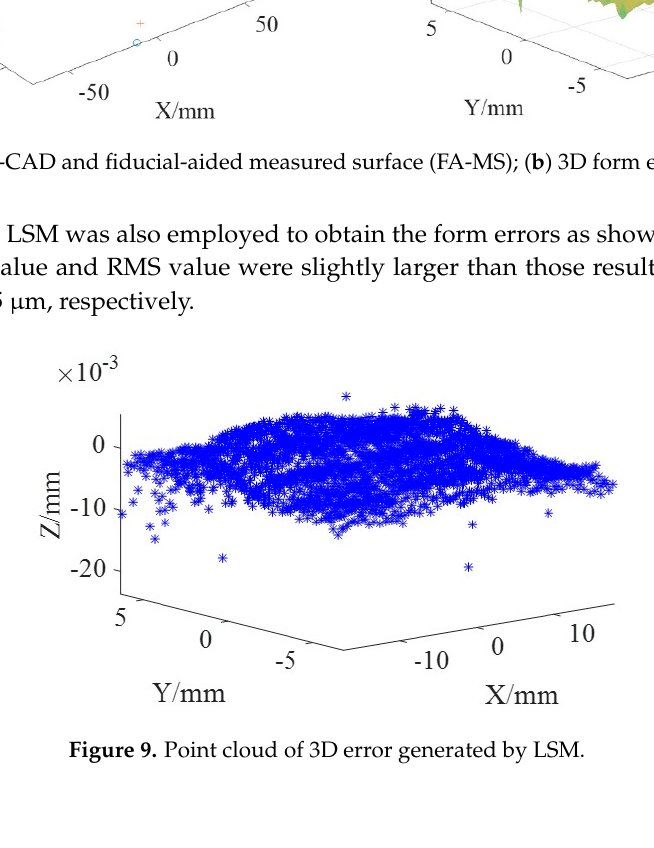
Figure 8. ( a ) FA-CAD and fiducial-aided measured surface (FA-MS); ( b ) 3D form error evaluation.